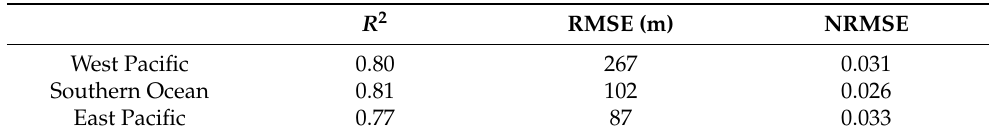
Table 3. The overall precision of the